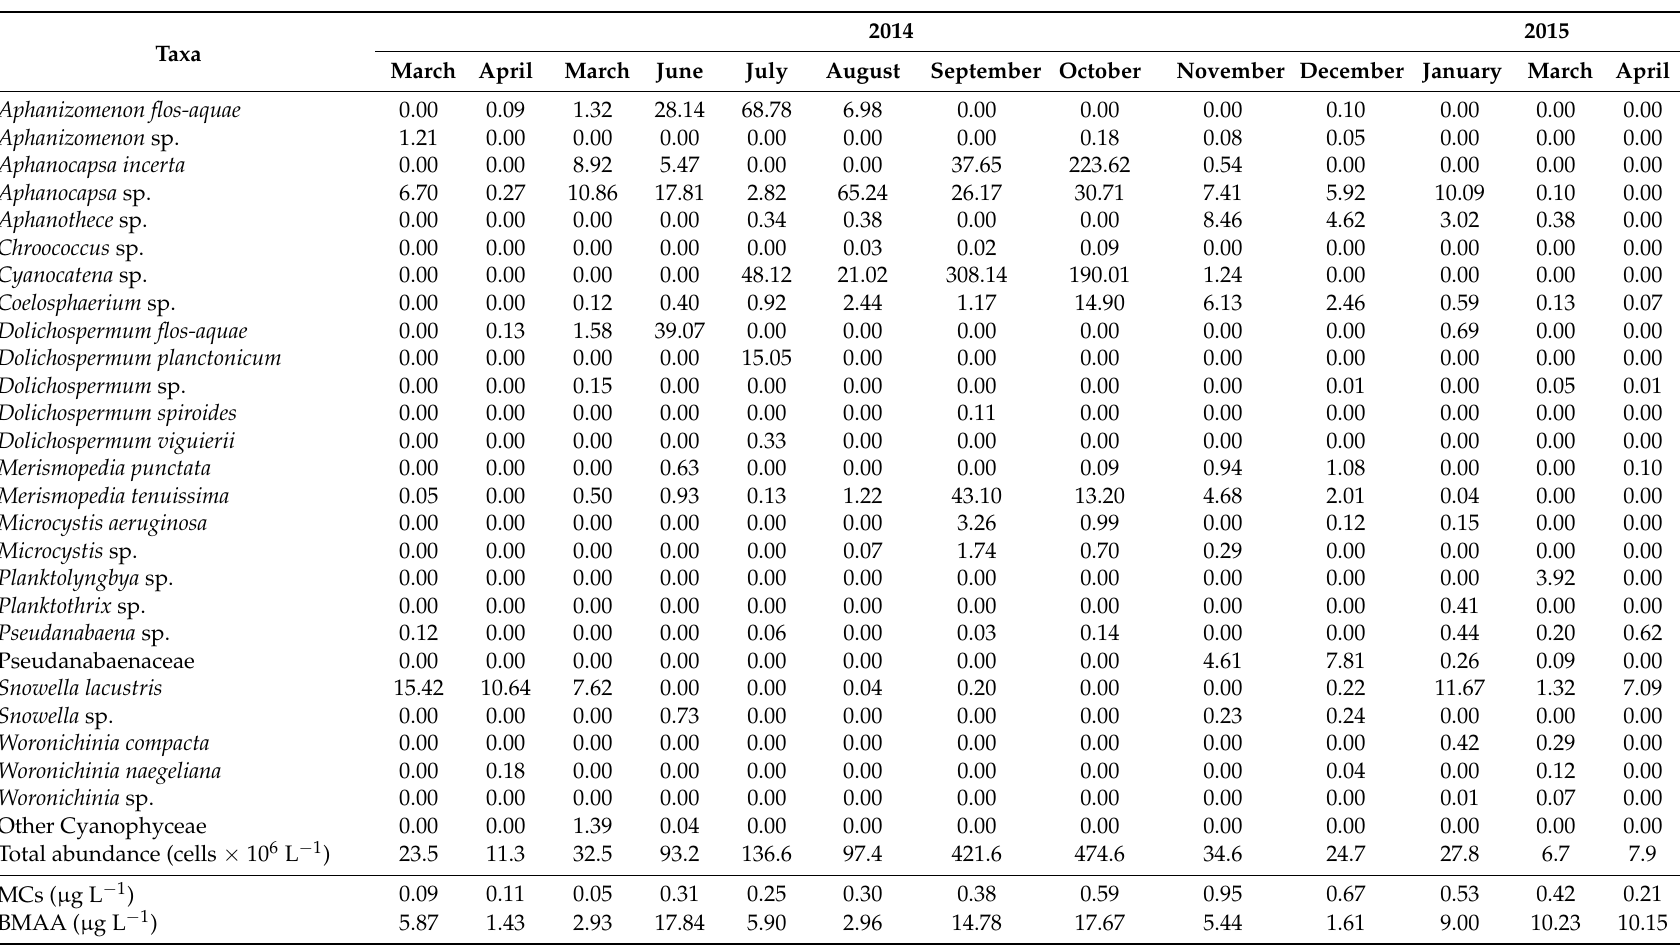
Table 3. List of cyanobacteria taxa, abundances (cells × 10 6 L − 1 ) and measured cyanotoxins in Lake Bidighinzu in the study